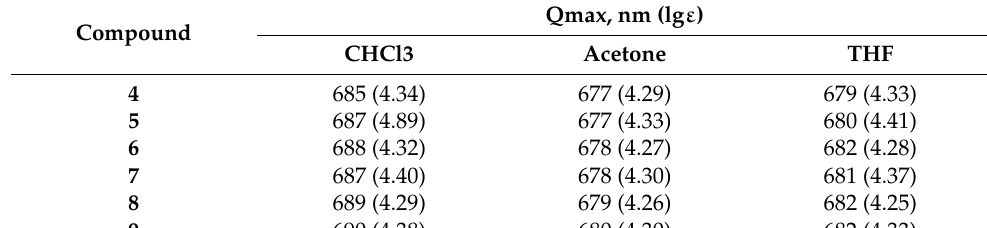
Table 1. Spectroscopic characteristics of compounds 4 – 9 in organic media.